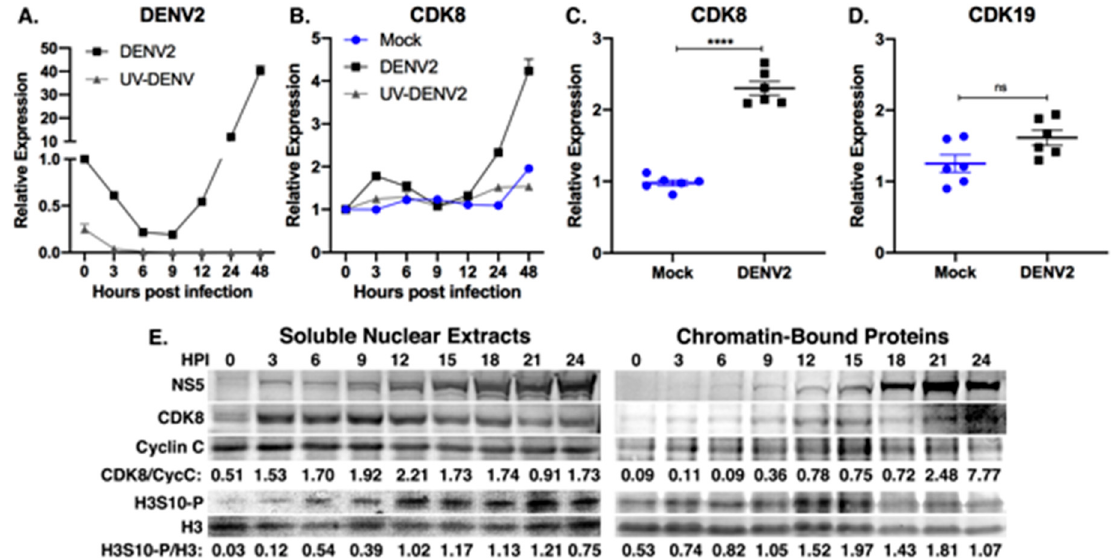
Figure 1. CDK8 is upregulated during DENV infection. ( A , B ) Huh7 cells were either mock-infected, infected with DENV at MOI 10, or treated with equivalent UV-inactivated DENV2 (UV-DENV) over a time course of 48 h. Total cellular RNA was collected at indicated time points after infection and analyzed by qRT-PCR for DENV RNA ( A ), and CDK8 mRNA expression ( B ), relative to the time of infection and normalized to the housekeeping gene, SDHA . Results are representative of two independent experiments. ( C , D ) CDK8 ( C ) and CDK19 ( D ) mRNA expression in mock or DENV-infected Huh7 cells after 36 h of infection at MOI 10 (n = 6 biological replicates; **** p < 0.0001 unpaired, two-tailed t test). Error bars represent mean +/ − SEM). ( E ) Western blot analyses of 10 µg of total protein from nuclear extracts (Soluble Nuclear Extracts) and from the remaining, salt-extracted chromatin fraction (Chromatin-Bound Proteins) from cells collected every three hours for 24 h after infection. Antibody specificities are indicated as are the relative band densities of CDK8 versus Cyclin C and histone H3 phosphorylated at serine in position 10 (H3S10-P) versus total histone H3 (H3). Infection was confirmed by presence of nuclear DENV2 NS5. The results are representative of three separate time-course infections.